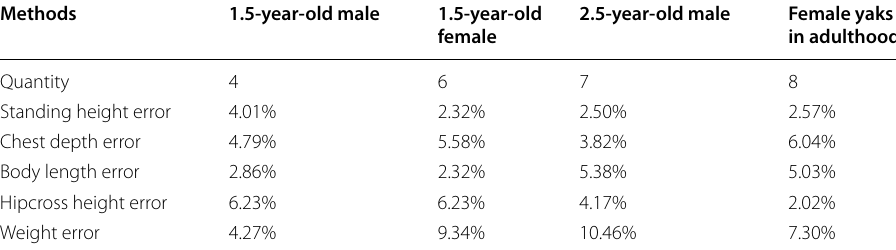
Table 7 Data validation results of 25 yaks in different age groups Methods